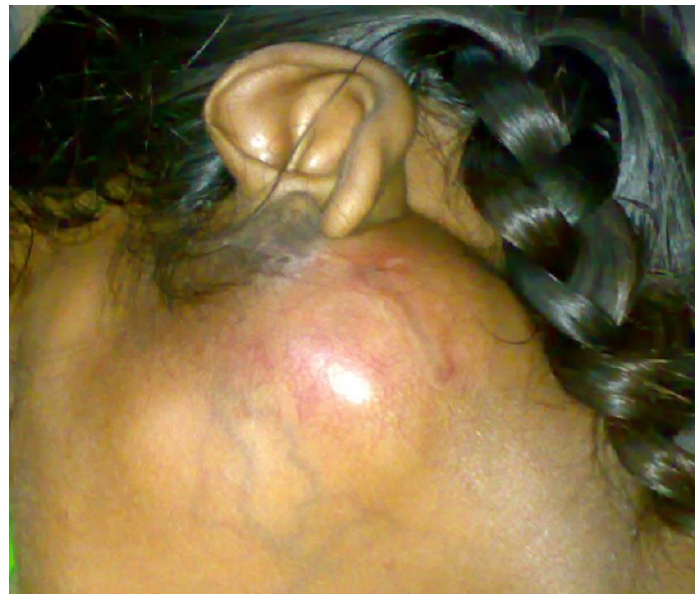
Figure 1. Initial presentation of the patient with a well-defined swelling below the left earlobe.